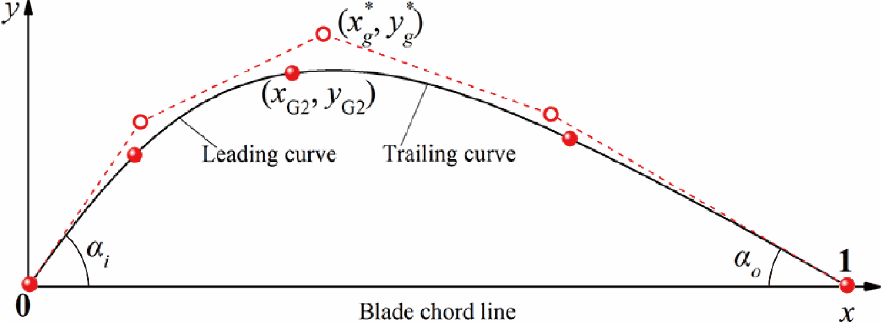
Figure 2. Blade camberline geometry and parameters. According to the properties of NURBS curves, when the first and last control points have fourfold knots, the first and last control points of a NURBS curve are the initial and terminal points on the curve itself. Since the leading edge is at (0, 0) and the trailing edge is at (1, 0), then